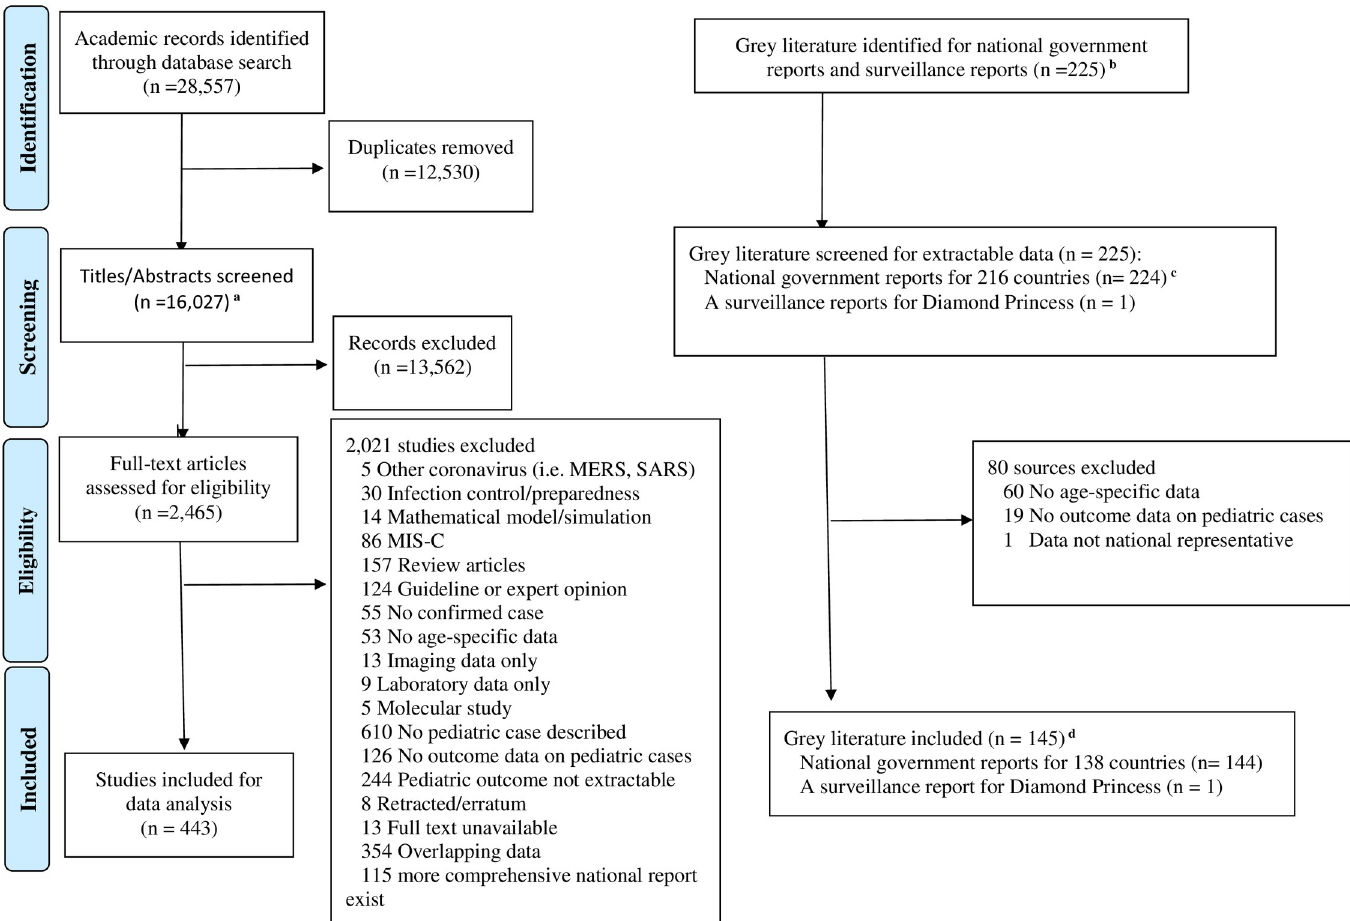
Fig 1. PRISMA flowchart. a Included two manually extracted article. b No national data from North Korea and Turkmenistan was identified. c Aggregated data from more than one eligible reports identified, screened, and included for data analysis/synthesis for 6 countries (Estonia, Namibia, Romania, Rwanda, United Kingdom, and the United States of America). d National reports from 8 countries (Burkina Faso, Cyprus, Guinea, Kazakhstan, Kenya, Oman, Pakistan, and Trinidad Tobago) were not included into primary analysis because they were reported more than 2 months before the date of final search (Dec 7, 2020), but they are included into the sensitivity analysis. MIS-C: Multisystem inflammatory syndrome in